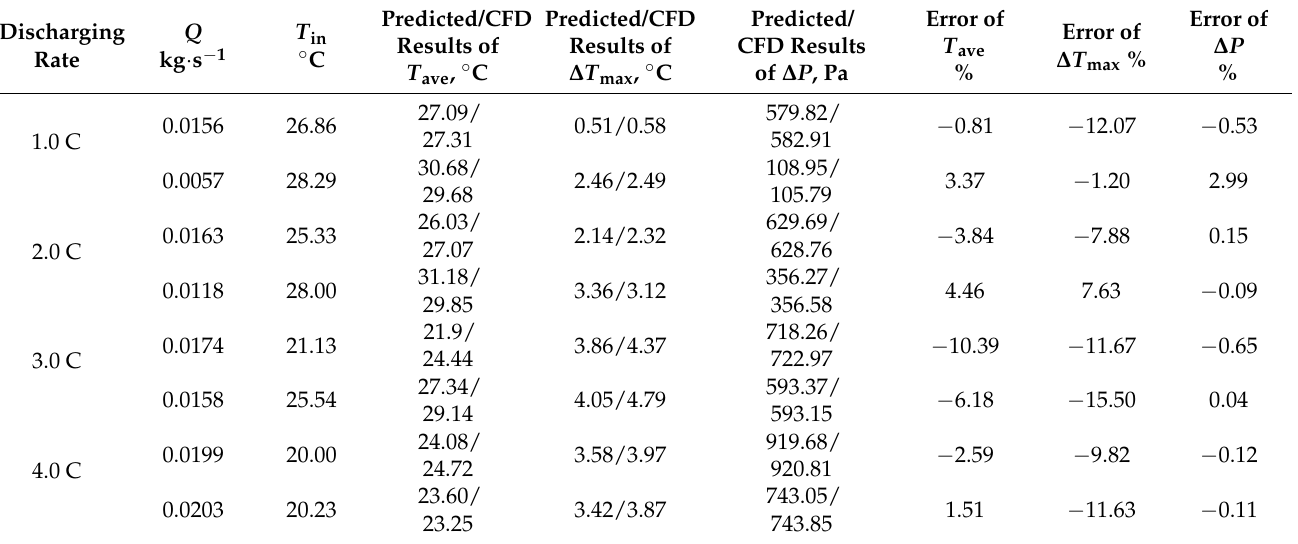
Table 7. Accuracy verification of Pareto optimal